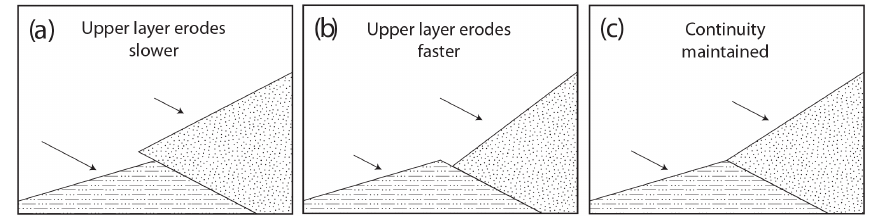
Figure 2. Erosional continuity. (a) If the upper layer at a contact erodes slower, this produces a discontinuity at the contact and the resulting steepening or undercutting of the upper layer will drive the system toward erosional continuity. (b) If the upper layer erodes faster, this produces a low or reversed slope zone near the contact, which will also drive the system toward continuity (c) We hypothesize that, in general, topography will tend to approach a state where continuity is